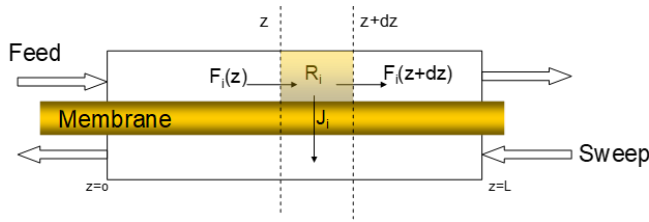
Figure 5. Schematic overview of the membrane model. Here, the trans-membrane flux for each component i is described as a function of the dimensionless membrane length z according to Equation (1).